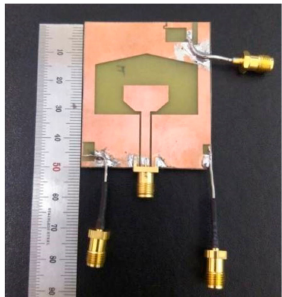
Figure 14. Photograph of the proposed antenna.